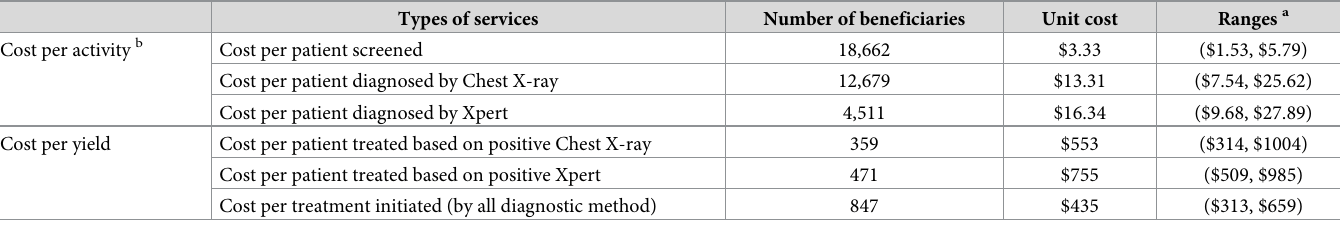
Table 2. Service volumes and unit costs associated with an active case finding program for tuberculosis in Zambia.